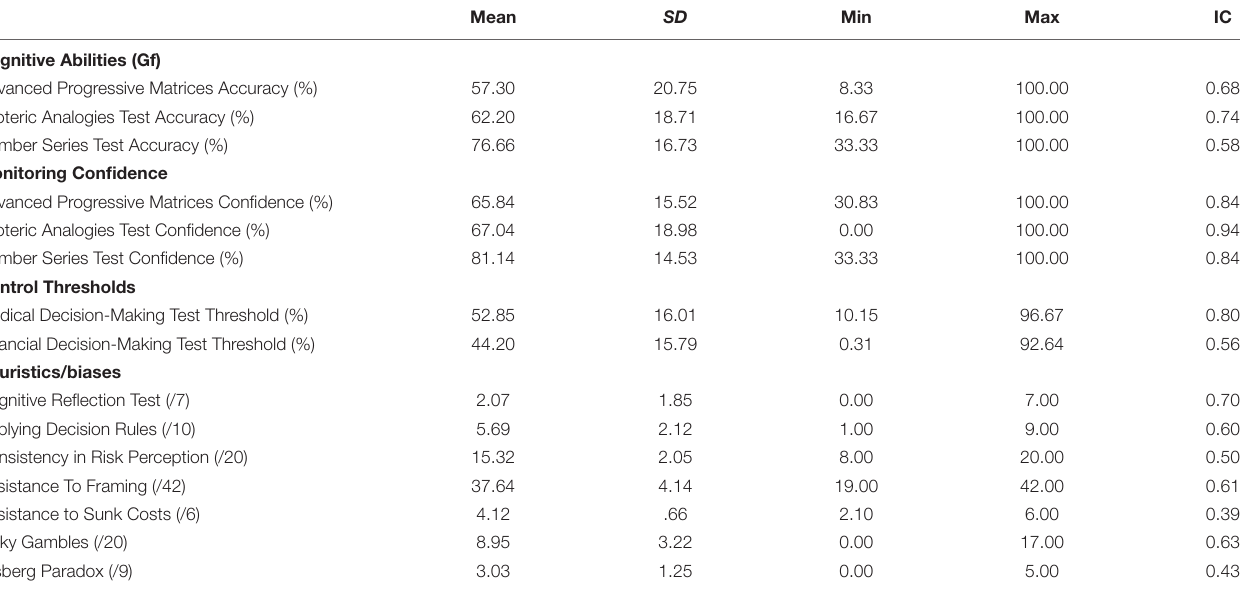
TABLE 1 | Descriptive statistics for all